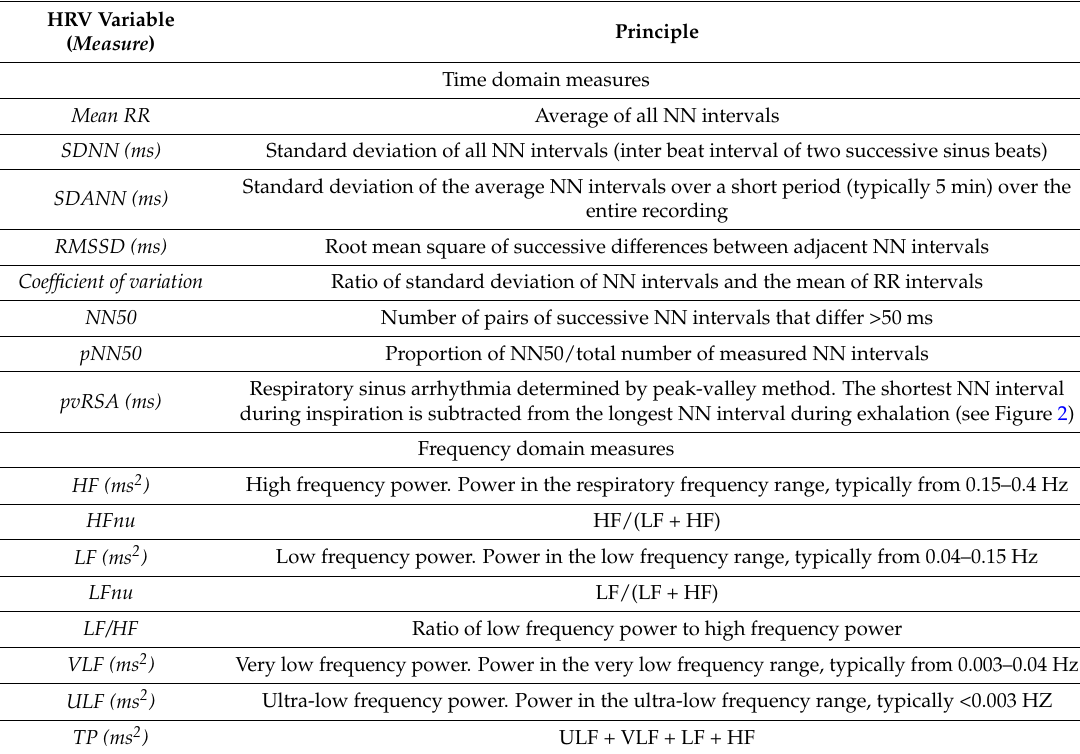
Table 1. Heart rate variability (HRV) based measures. Ms;